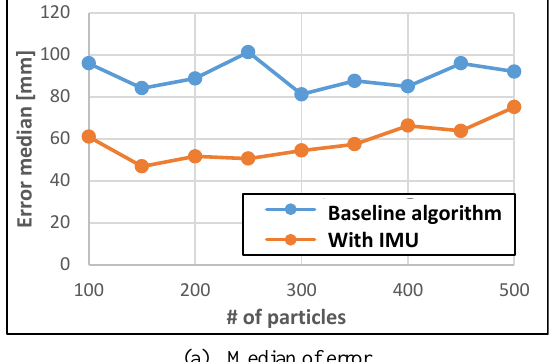
Figure 8. Processing time per frame in different particle settings